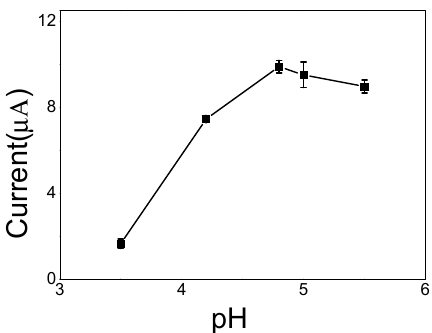
Figure 9. Relationship between stripping peak values recorded form SWASV responses and different pH in 10 ng/mL Cd(II) standard solution.